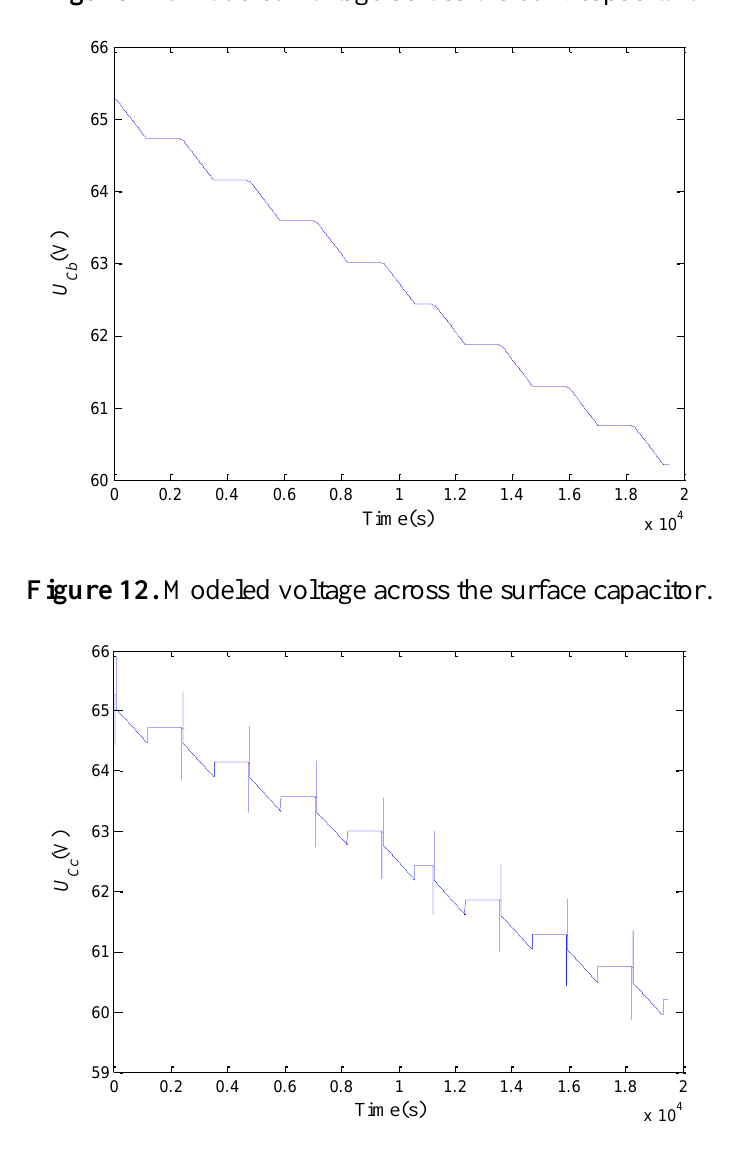
Figure 11. Modeled voltage across the bulk capacitor.